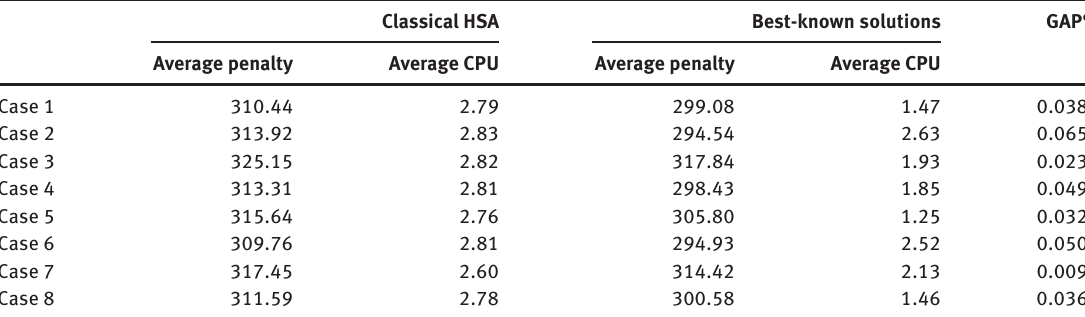
Table 7: Computational Results for Classical